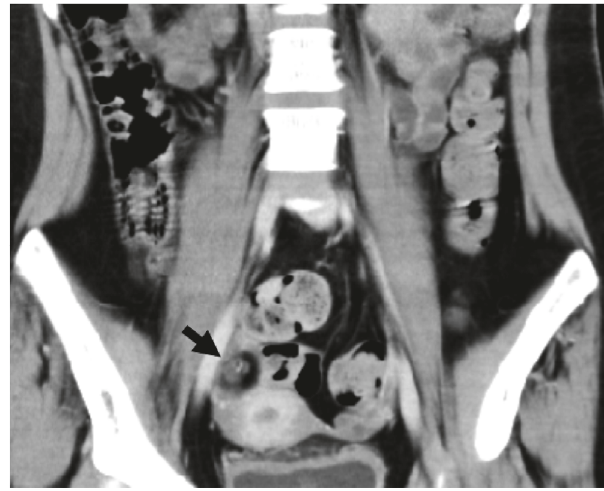
Figure 2: Abdominal CT after 8 months of admission demonstrat- ing a small ovarian calcified cystic mass on the right side